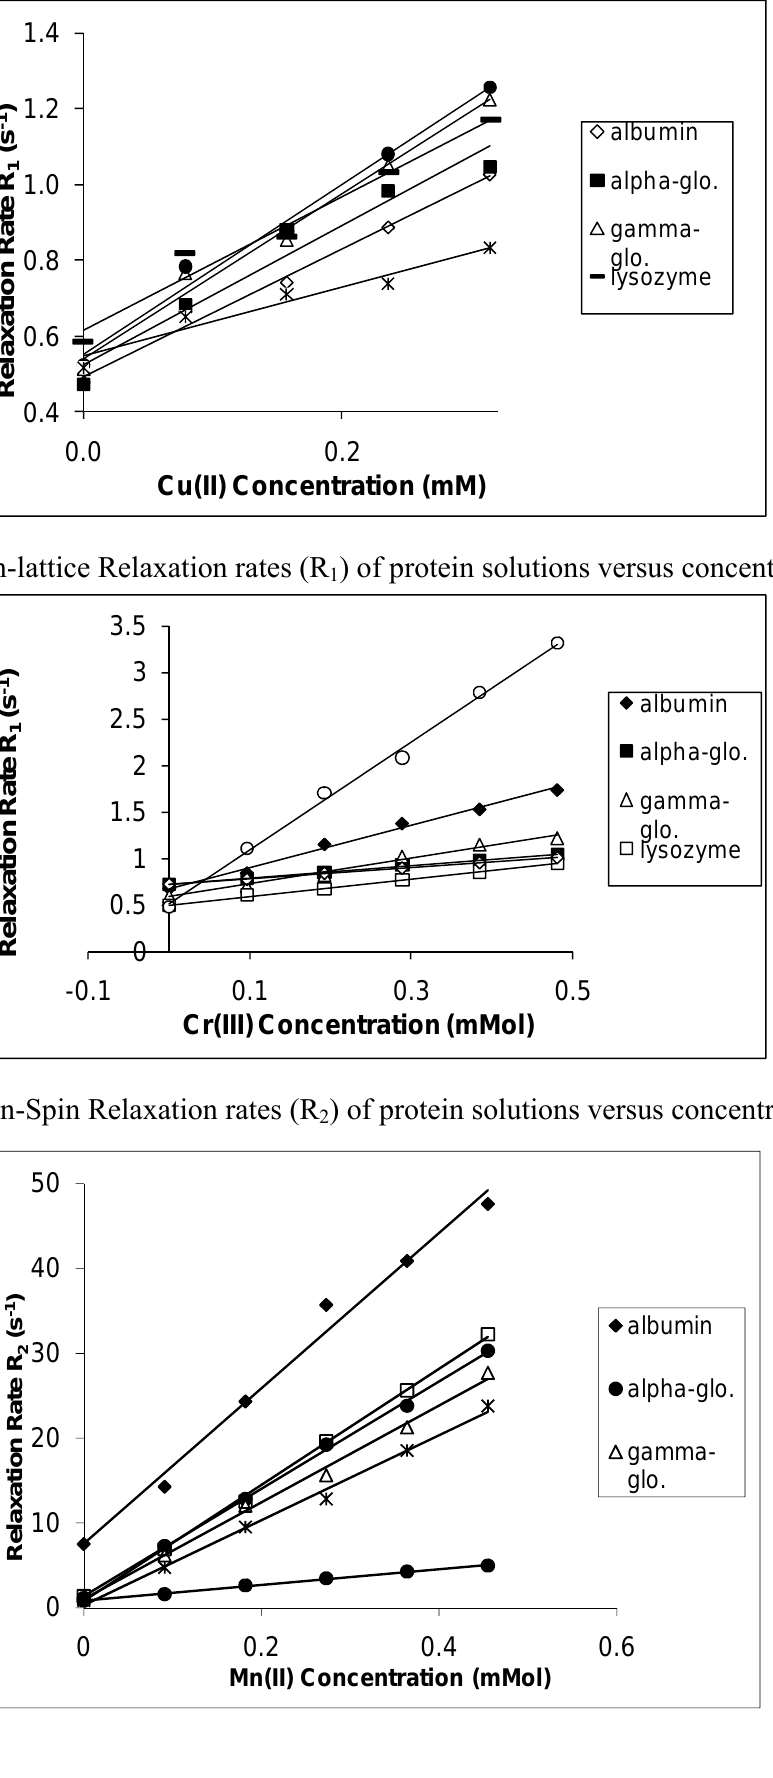
Figure 2. The Spin-lattice Relaxation rates (R